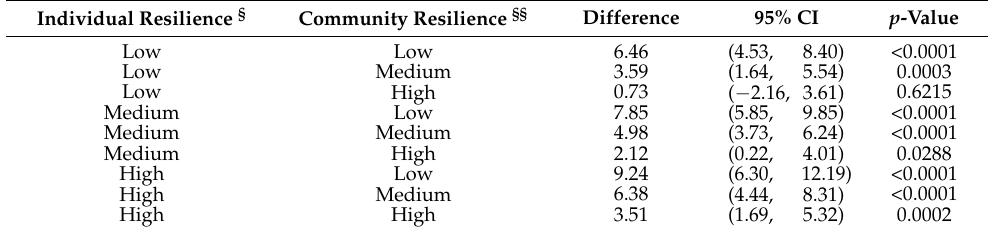
Table 3. Comparisons in suicidal ideation between participants with and without familiarity with structural stigma in the form of transgender sports ban legislation in low, medium, and high levels of individual resilience and community